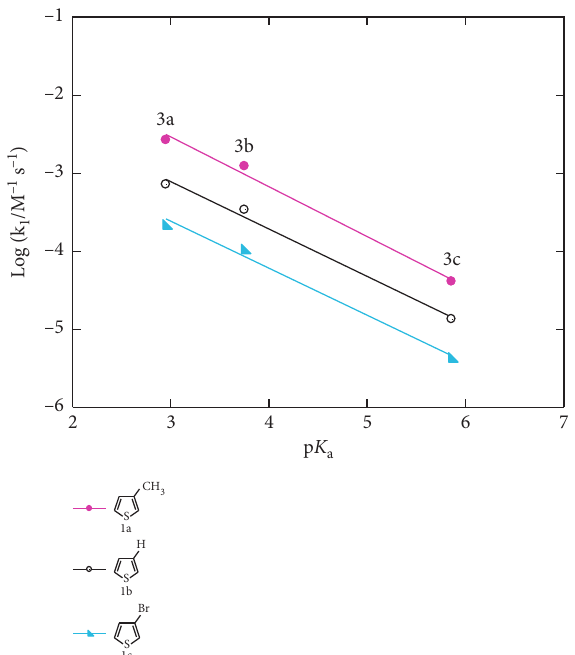
Figure 8: Br¨onsted linear correlations for the coupling reaction of the thiophenes 1a-c with the electrophiles 3a-c in acetonitrile at 20 ° C.